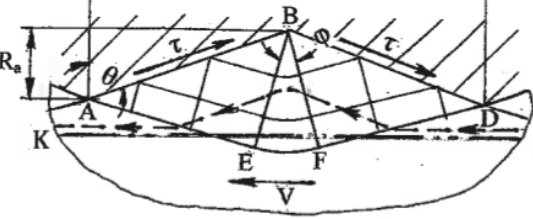
Figure 12. Slip line solution around an asperity during friction SPD.